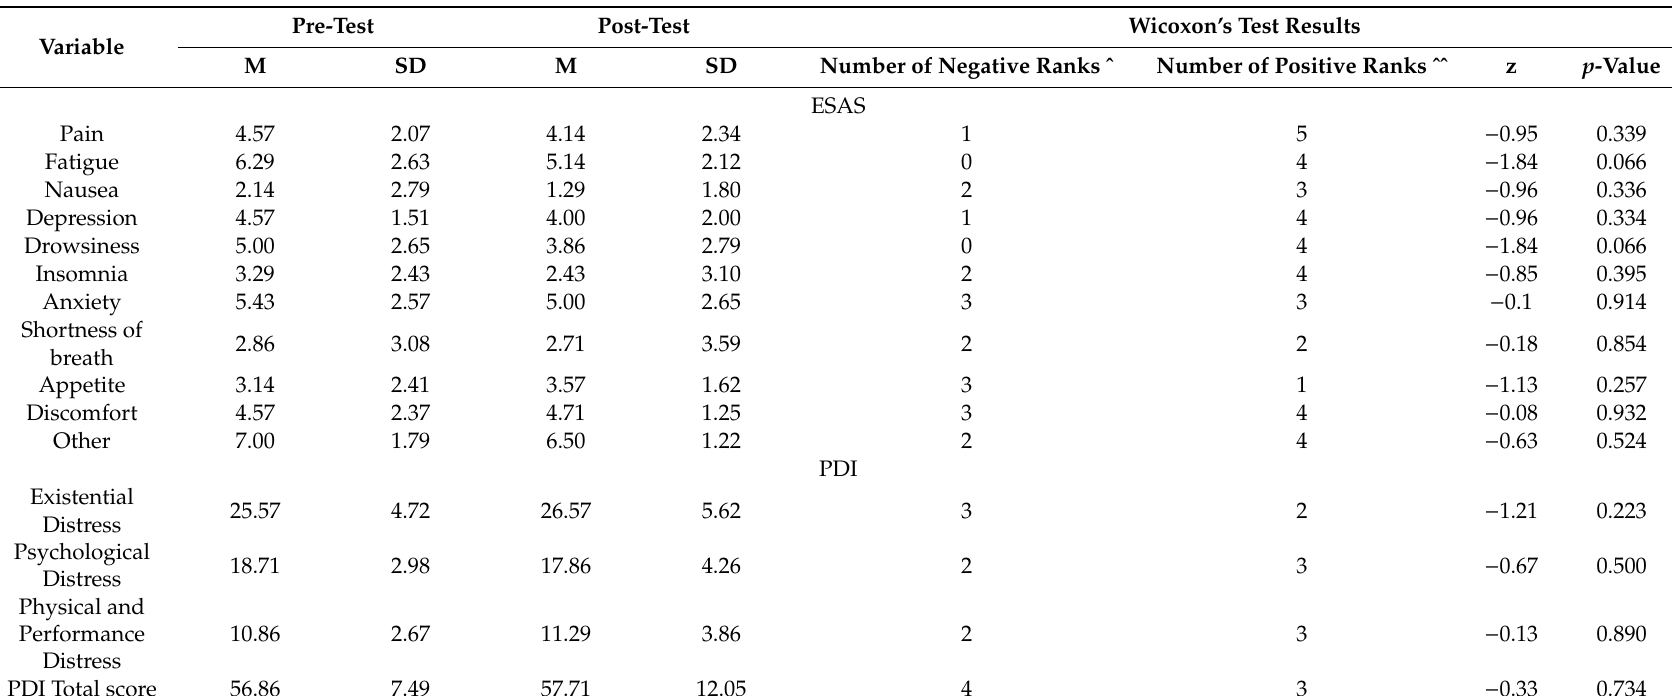
Table 2. Descriptive statistics and Wilcoxon’s test to compare pre-test and post-test for Edmonton Symptom Assessment Scale (ESAS) and Patient Dignity Inventory